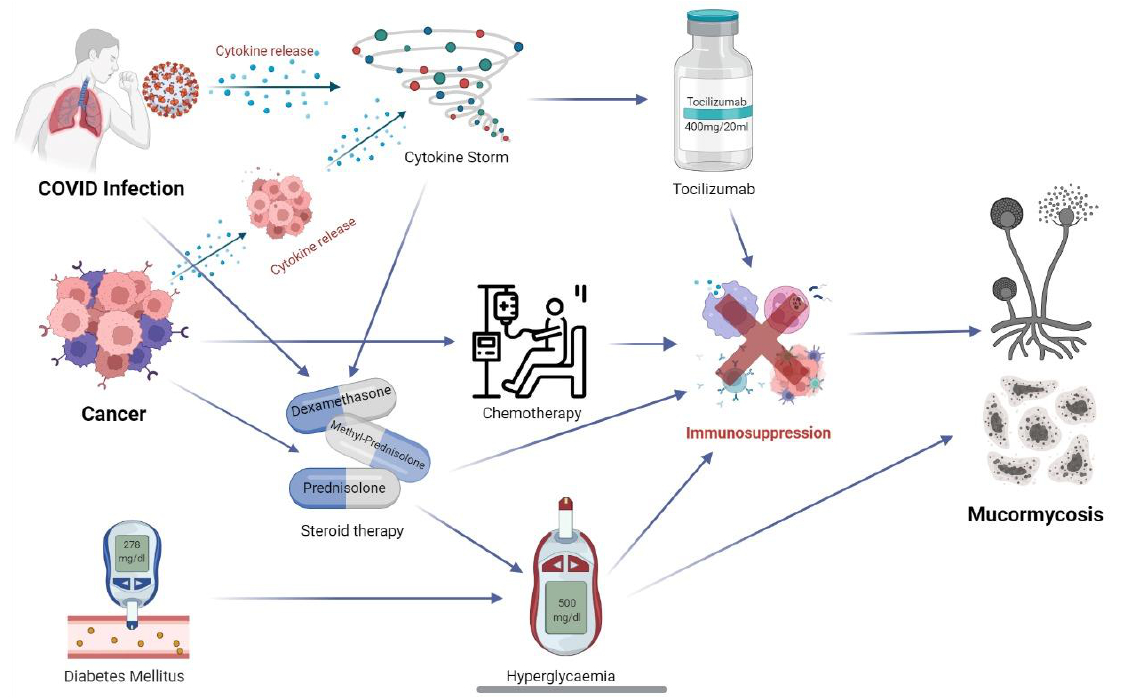
Figure 1. An illustration summarising the interwoven relationship between COVID-19, mucormycosis and cancer.